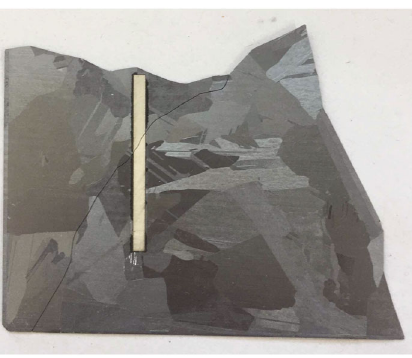
Figure 3: Bottom part of solar cell after removing aluminium layer.